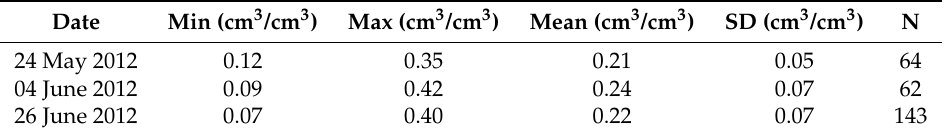
Table 1. The Terra-SAR data acquisition time (Date) and minimum (Min), maximum (Max), average (Mean), standard deviation (SD), and Number (N) of SSM measurement points.